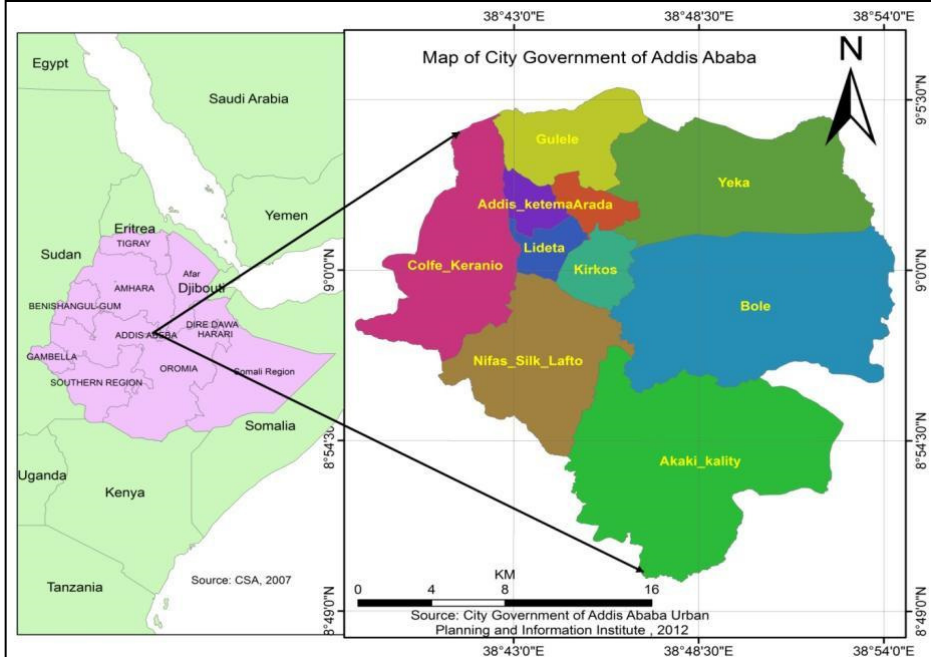
Figure 1. Map of Addis Ababa by subcities.